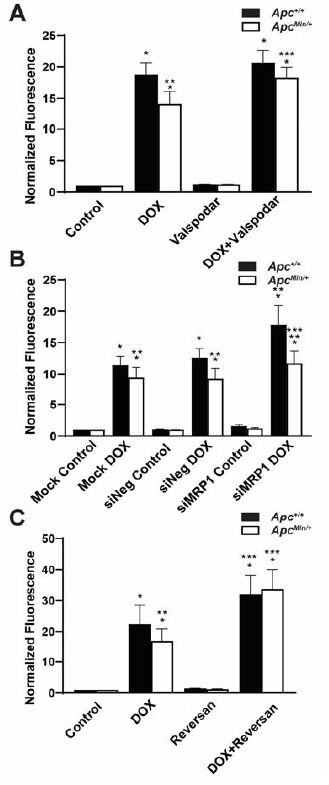
Figure 3. Increased MDR1 and MRP1 activity effluxes DOX extracellularly in APC-deficient cells. ( A ) MDR1 inhibition restores the accumulation of DOX in MMTV-PyMT; Apc Min/+ cells comparable to the accumulation of DOX in MMTV-PyMT; Apc +/+ cells. The mean fluorescence intensity (MFI) was normalized to that of the genotype control. ( B ) The accumulation of DOX increased in MMTV- PyMT; Apc Min/+ and MMTV-PyMT; Apc +/+ cells following MRP1 silencing. MFI was normalized to the genotype control. ( C ) Dual MDR1 and MRP1 inhibition increased intracellular DOX fluorescence in MMTV-PyMT; Apc Min/+ cells and MMTV-PyMT; Apc +/+ cells. MFI was normalized to the genotype control. * p < 0.05, comparing treated cells with control-treated cells; ** p < 0.05, comparing MMTV- PyMT; Apc Min/+ cells with MMTV-PyMT; Apc +/+ cells within the same treatment/transfection; *** p < 0.05, comparing the combination treatment with the DOX-only treatment.